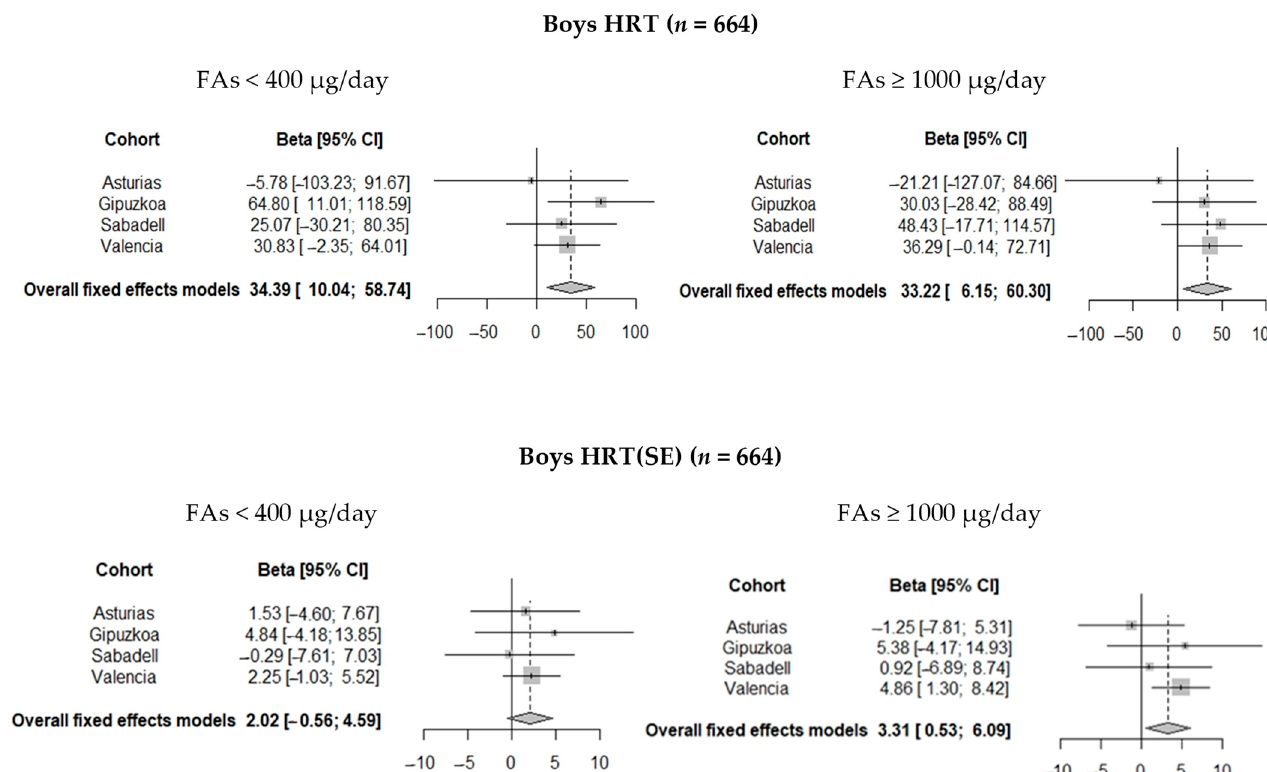
Figure 3. Pooled estimates of the associations between FAs (<400 and ≥ 1000 µ g/day compared to 400–999 µ g/day) and Conner’s Kiddie Continuous Performance Test (K-CPT) outcomes in boys at 4–5 years of age.